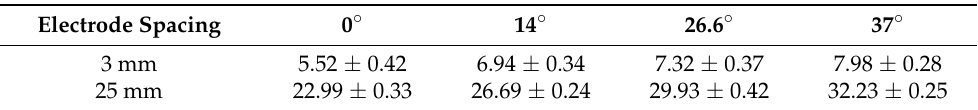
Table 2. The rectangular electrode APPT ablation characteristics of the propellant at various electrode flare angles, the unit of m bit is microgram. m bit [ug]